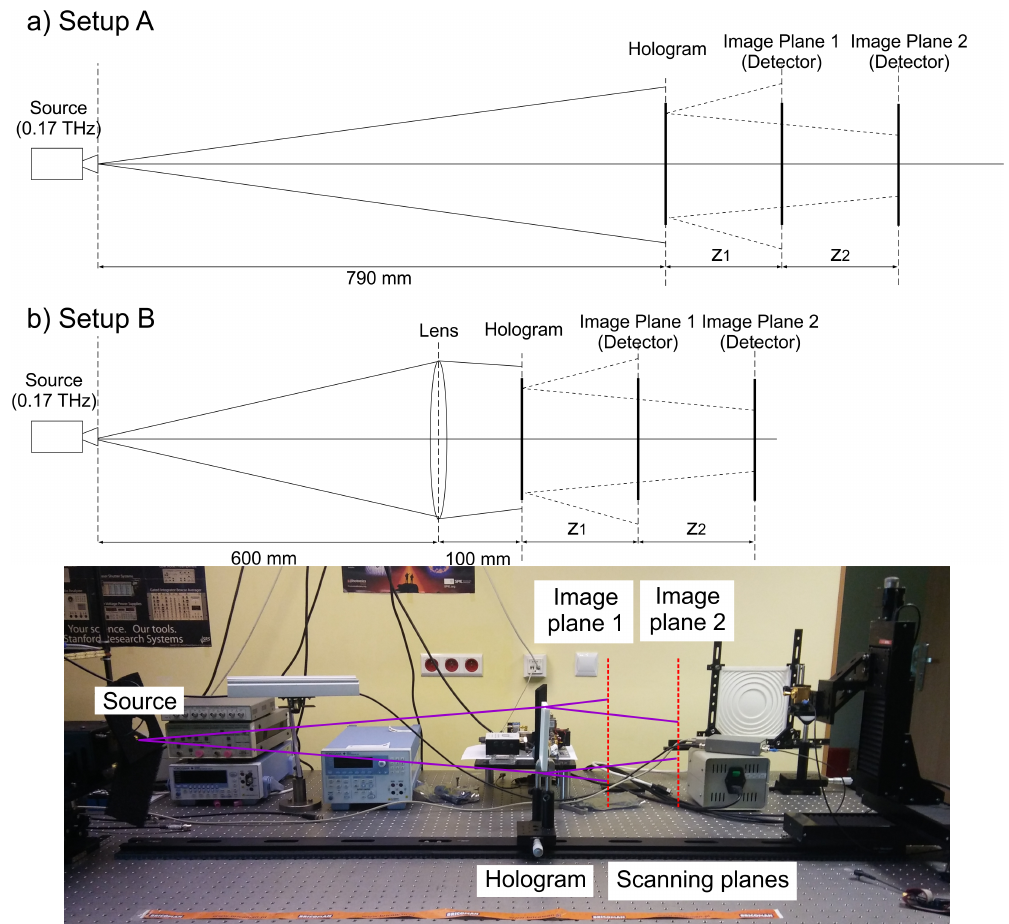
Figure 2. Schemes of the experimental setups and its photograph with marked paths of the beam and two image planes. The detector was moving on an XYZ